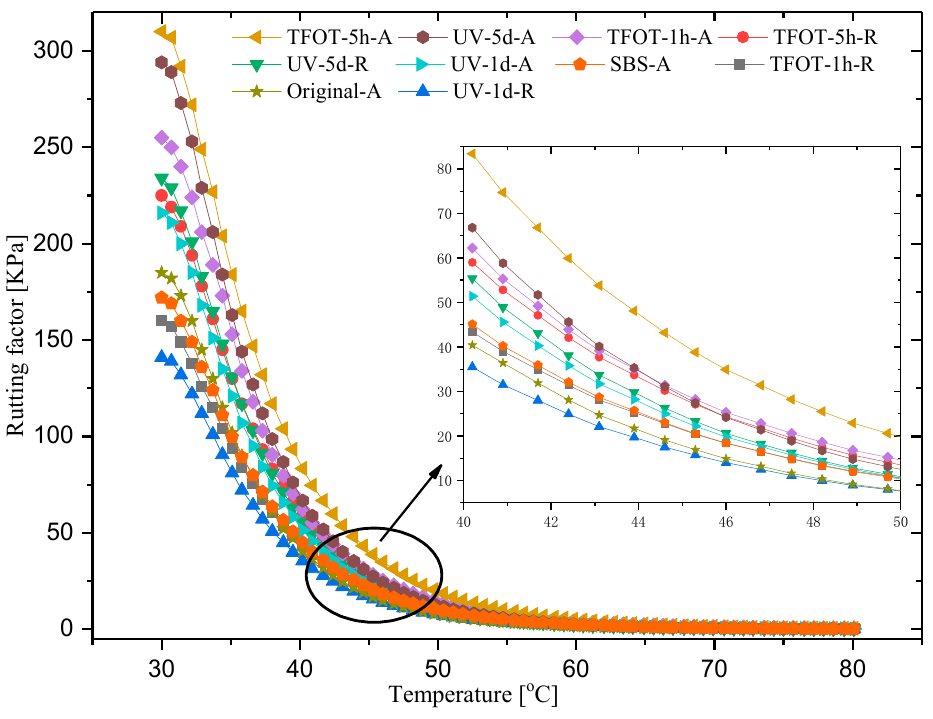
ff erent samples.